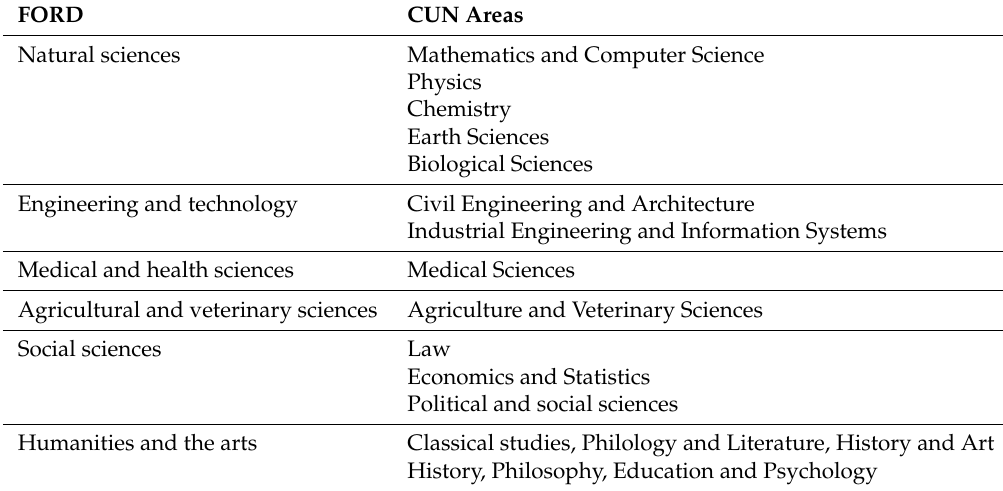
Table 8. The association between the main fields of research and development (FORDs) defined by the Frascati Manual (OECD 2002) and Italian scientific areas defined by The Italian National University Council